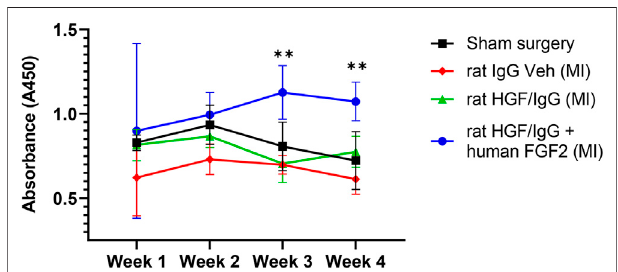
FIGURE 3 | Multiple administrations of HGF/IgG complexes do not induce HGF- speci fi c auto-antibodies in rats subjected to myocardial ischemia-reperfusion. After MI/R surgery or sham surgery, blood plasma was obtained from rats weekly and assessed for circulating antibodies speci fi c to rat HGF. Animals received three separate treatments: one at reperfusion, one on day 3, and one on day 5 post-MI/R with either vehicle (containing IgG), or HGF/IgG. HGF/IgG-treated animals showed no auto- immune reactivity to HGF. However, weekly addition of human FGF2 to